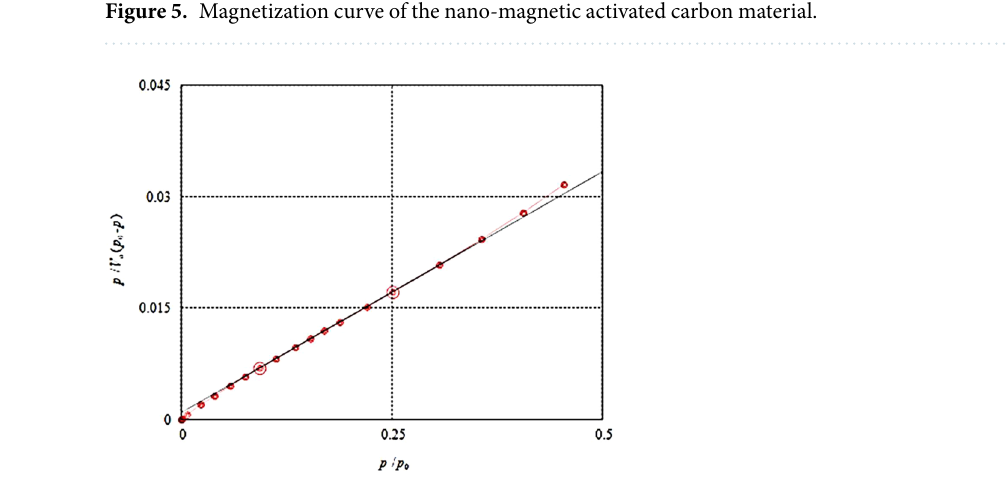
Figure 5. Magnetization curve of the nano-magnetic activated carbon material.